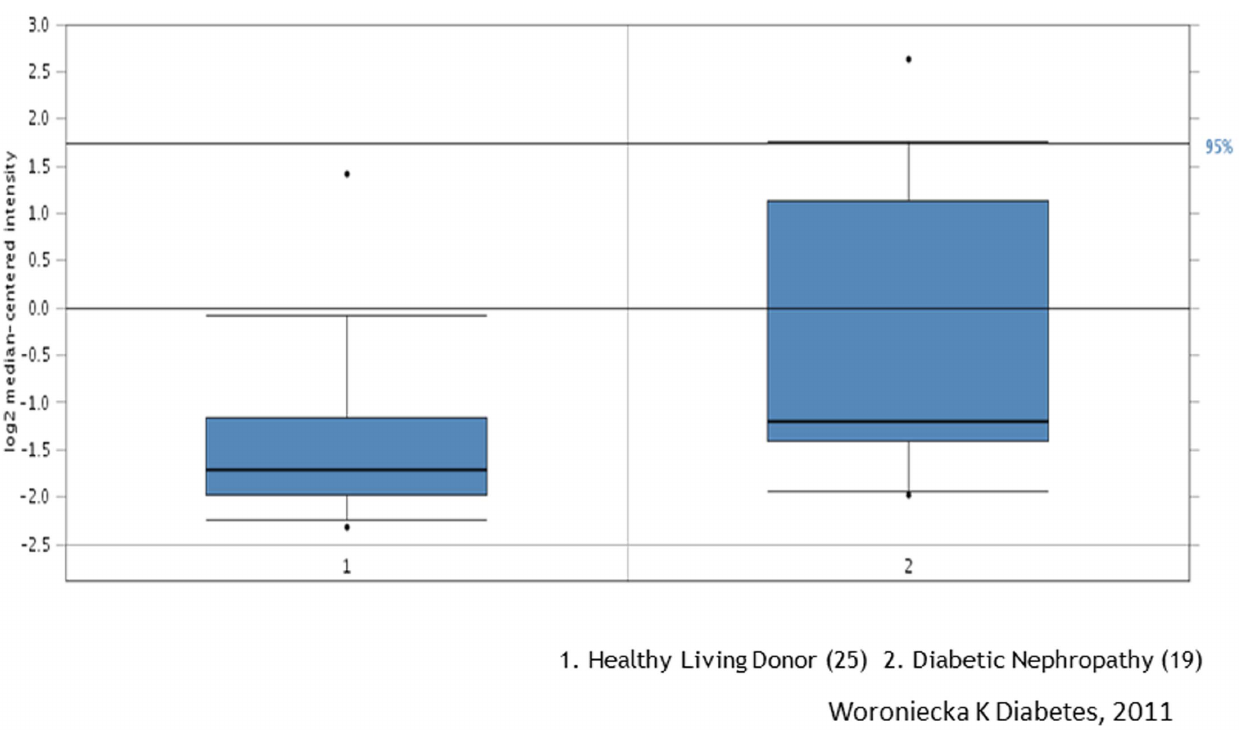
Figure 13. mRNA levels of Spon1 between diabetic kidneys and control kidneys. The data were obtained from Nephromine.org based on the datasets from the published studies [19].